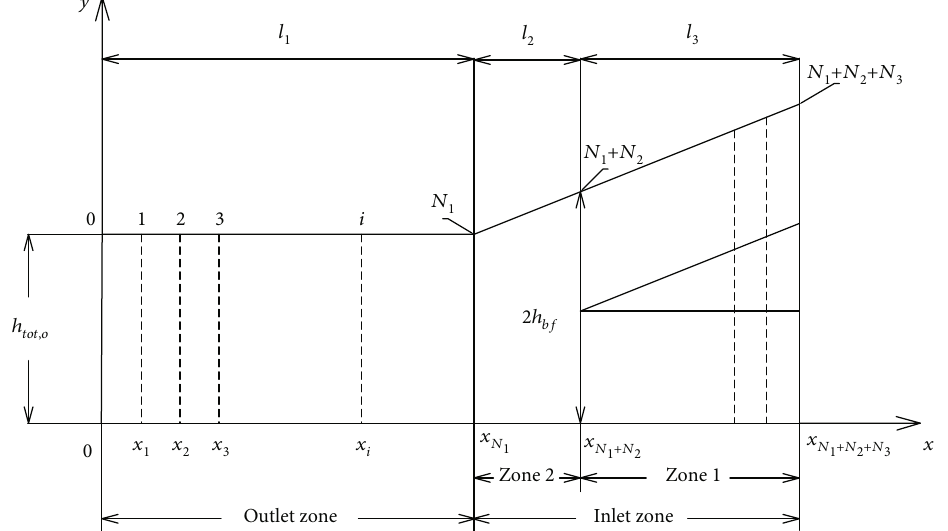
Figure 2: The ð N